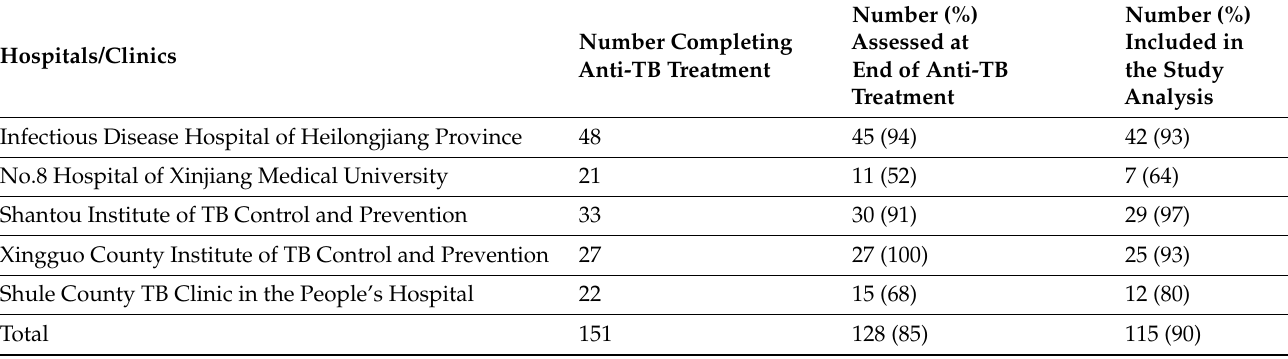
Table 3. Number of patients who completed anti-tuberculosis treatment and number (%) who were assessed and included in the study in the five healthcare facilities in China from April–June